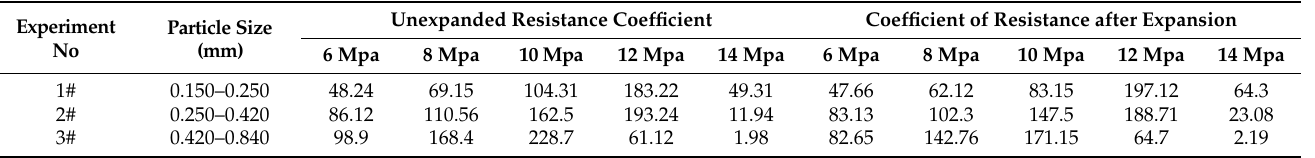
Table 10. Particle Drag Coefficient Data Sheet.